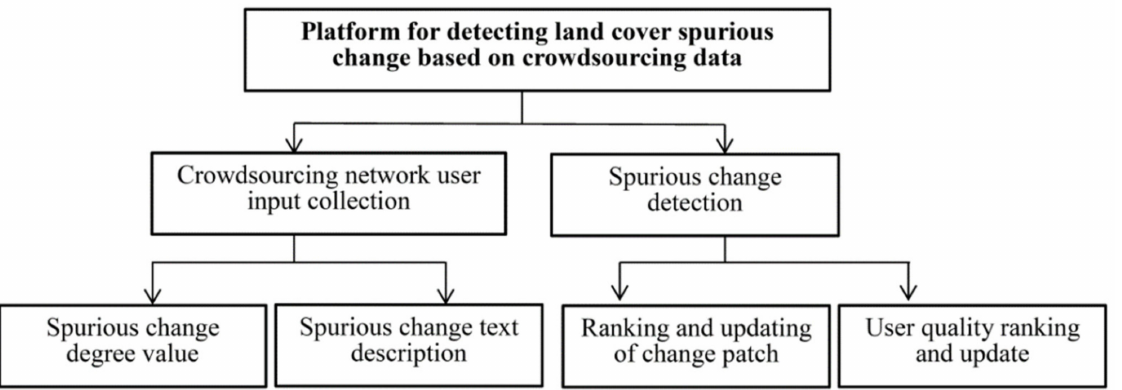
Figure 7. The function module diagram of the platform for detecting spurious land cover changes based on crowdsourced data.